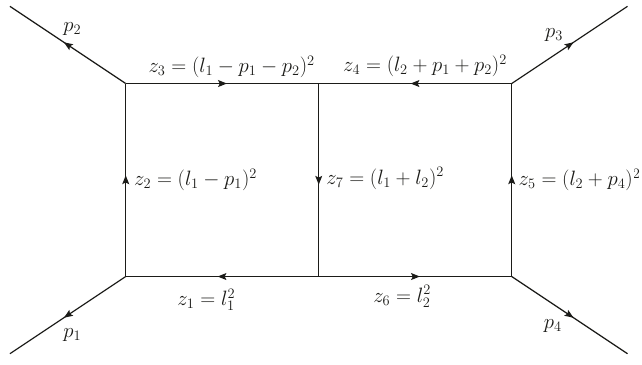
Figure 4 . The massless double box. The inverse propagators are labeled on the (cid:12)gure. The irreducible numerators are z 8 = ( l 1 + p 4 ) 2 and z 9 = ( l 2 + p 1 ) 2 . The external kinematic invariants are ( p 1 + p 2 ) 2 = s and ( p 2 + p 3 ) 2 = t